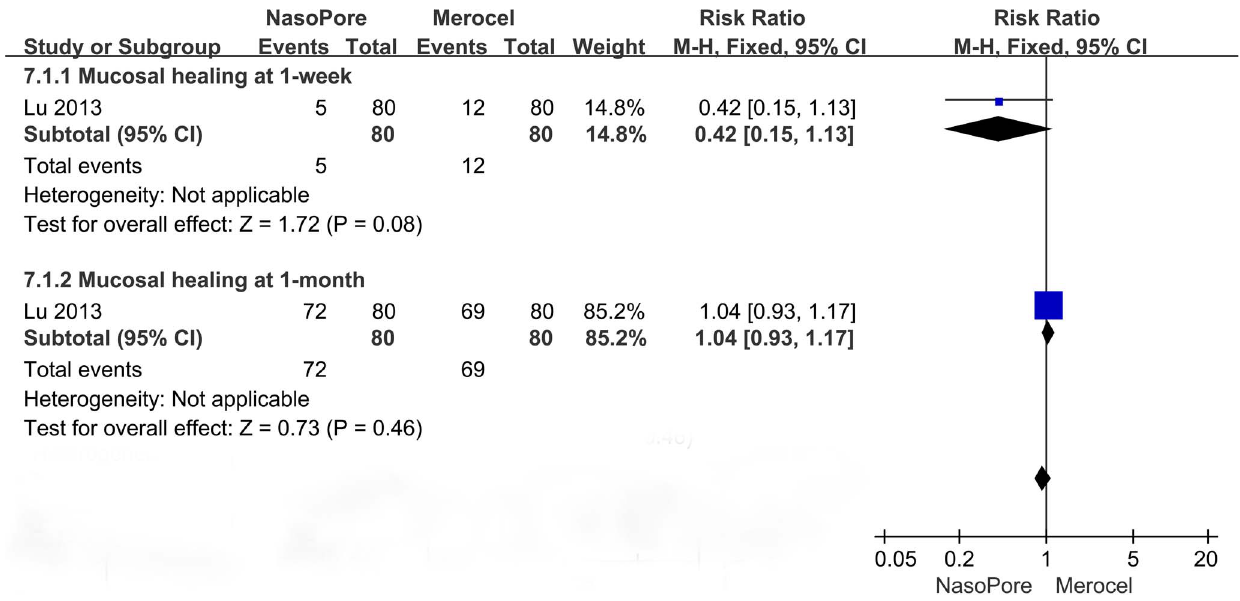
Figure 7. Forest plots of RR and 95% CI for mucosal healing at 1-week and 1-month.